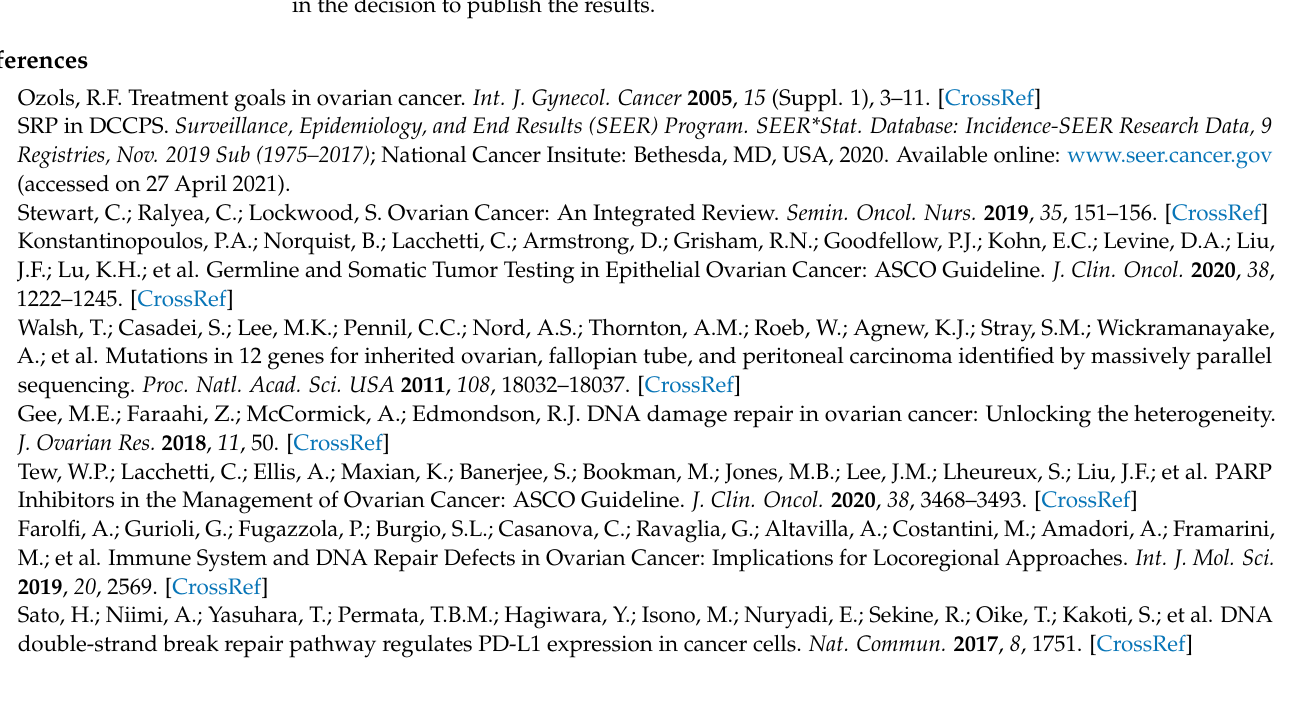
OV1921 PD-L1, Figure S4: OV1501b Full RADD, Figure S5: OV1501b oxRADD, Figure S6: OV1501b PD-L1, Figure S7: BC110118A1 Full RADD, Figure S8: BC110118A1 oxRADD, Figure S9: BC110118A1 PD-L1, Table S1: OV1921 TMA, Table S2: OV1501b TMA, Table S3: BC110118A1